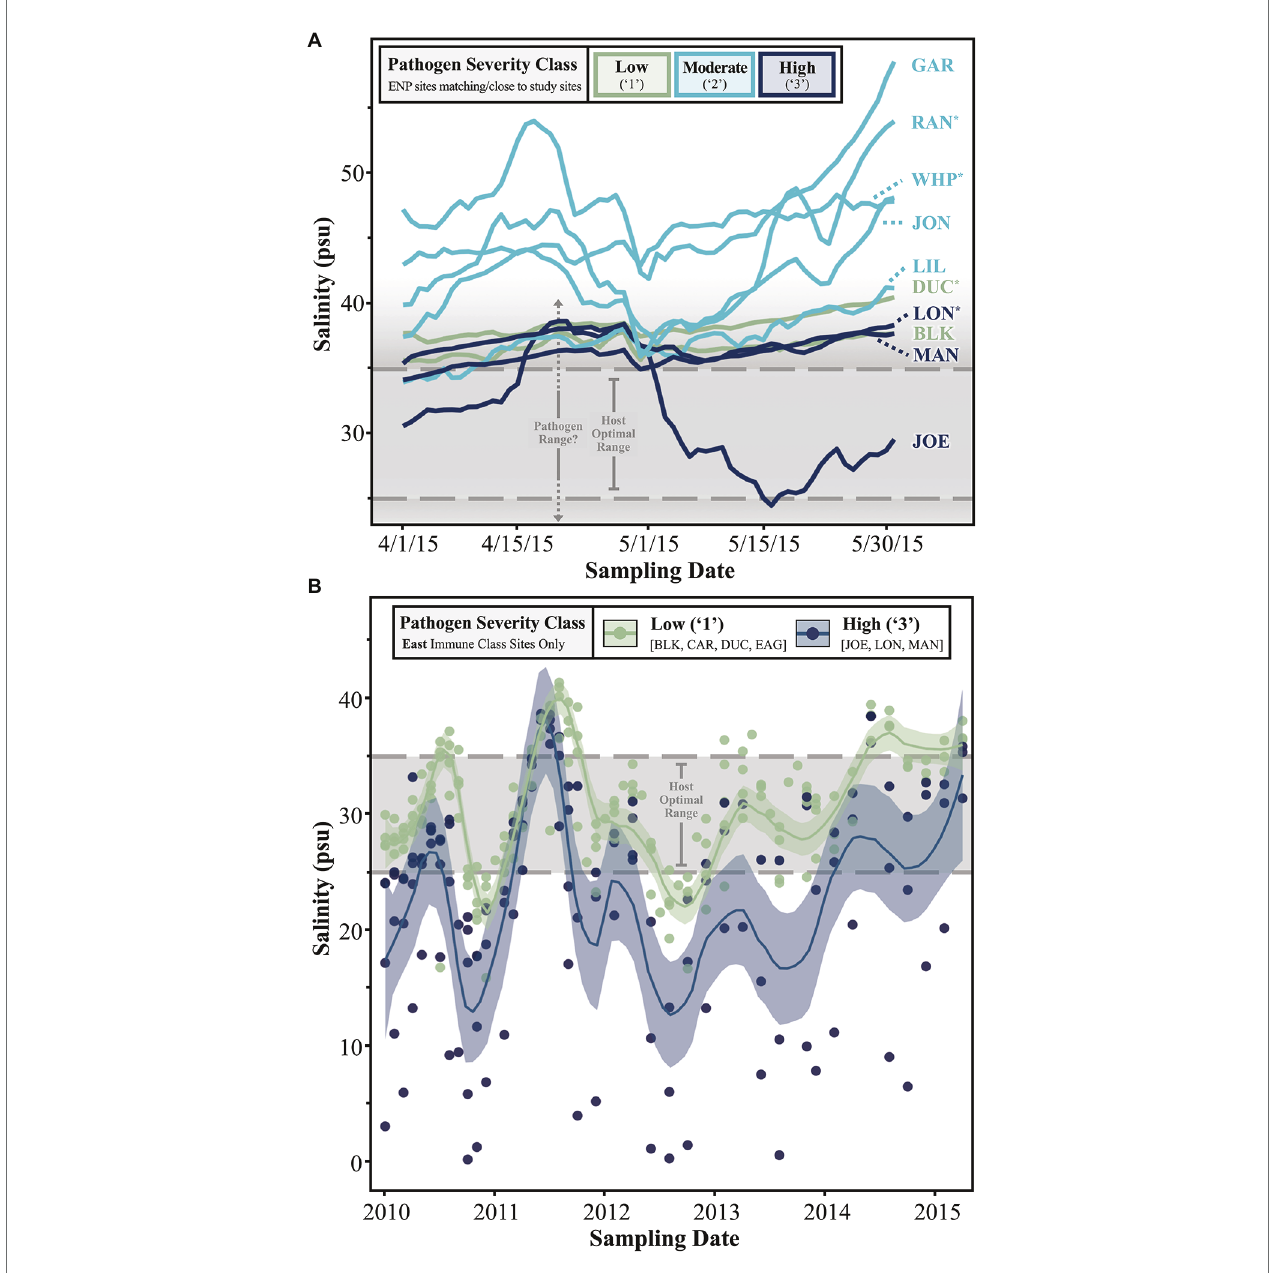
FIGURE 5 | Line graphs depicting trends in (A) short- and (B) long-term salinity measurements collected from either (A) all ENP sites in close proximity to our study sites or (B) permanent FHAP transects/our study sites falling within the “East” immune class. In part (A) , the data represents ENP station sampling points but are named according to our study sites/FHAP basins they pair with. Asterisks (*) denote study sites with nearby, but not perfectly complementary, ENP stations. See Supplementary Figure 1 for